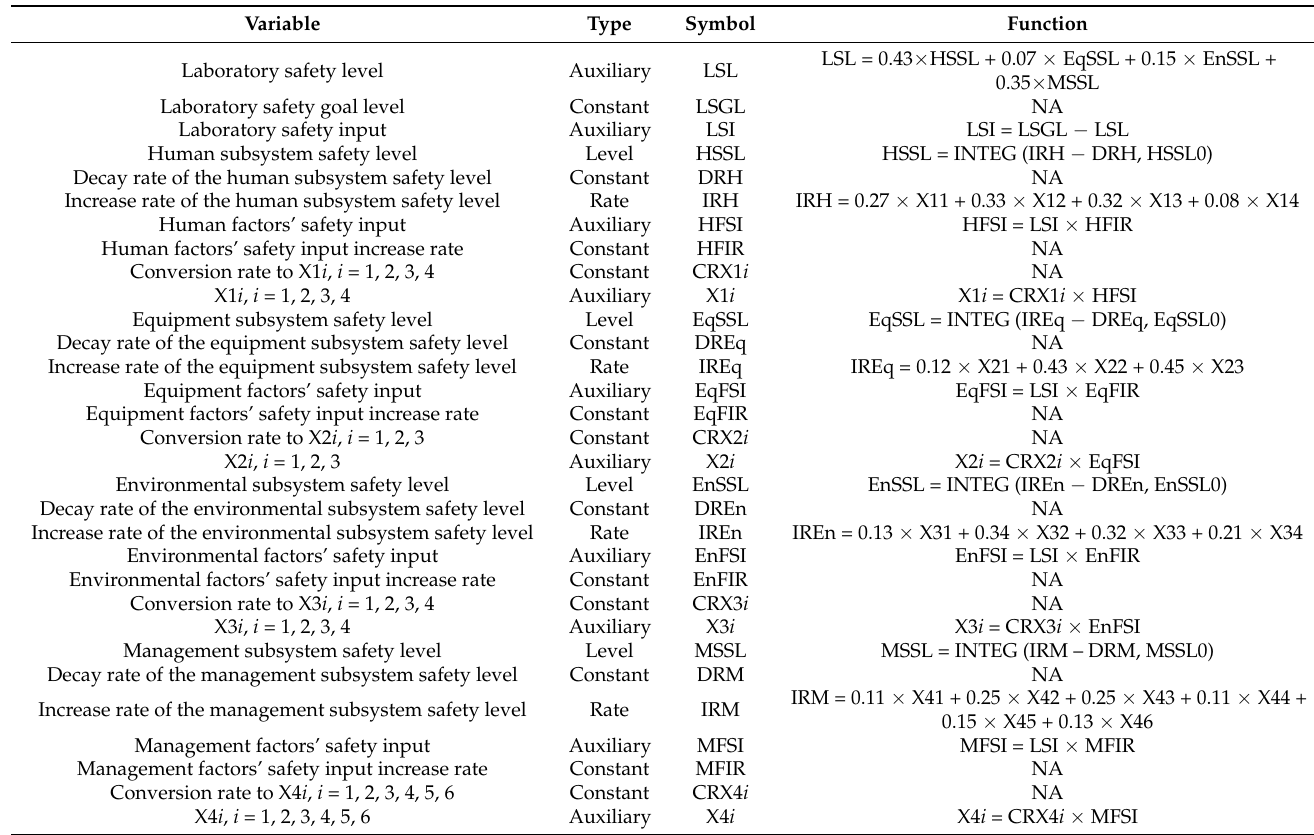
Table 9. Variables and functions in the SD